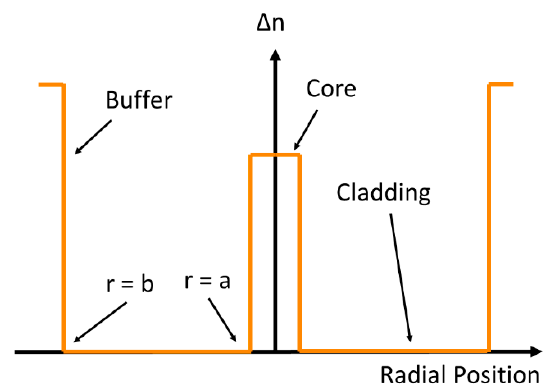
Figure 1. Refractive index profile (RIP) for a conventional step-index optical fiber.